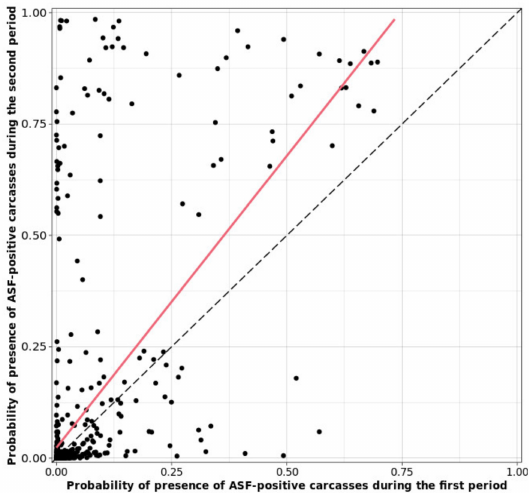
Figure 6. Scatter plot for the relationship between the probability of presence of ASF-positive wild boar carcasses for the first and second periods. Red line indicates the positive relationship between the probabilities of presence of ASF-positive carcasses for the two periods. Black dashed line indicates the diagonal line to help to understand the relationship between the probabilities of the two